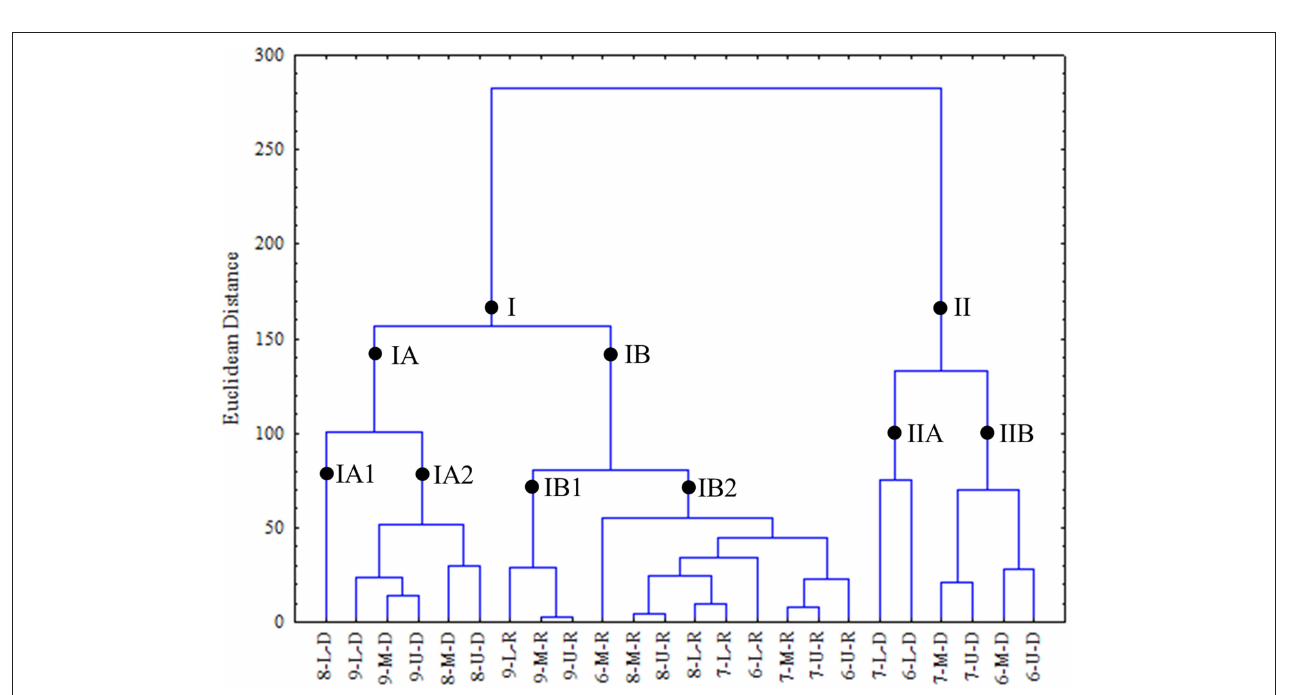
FIGURE 7 | Average ( ± standard deviation) of temporal (interannual and seasonal) variations of Secchi depth at the Goiana River estuary from 2006 to 2009.